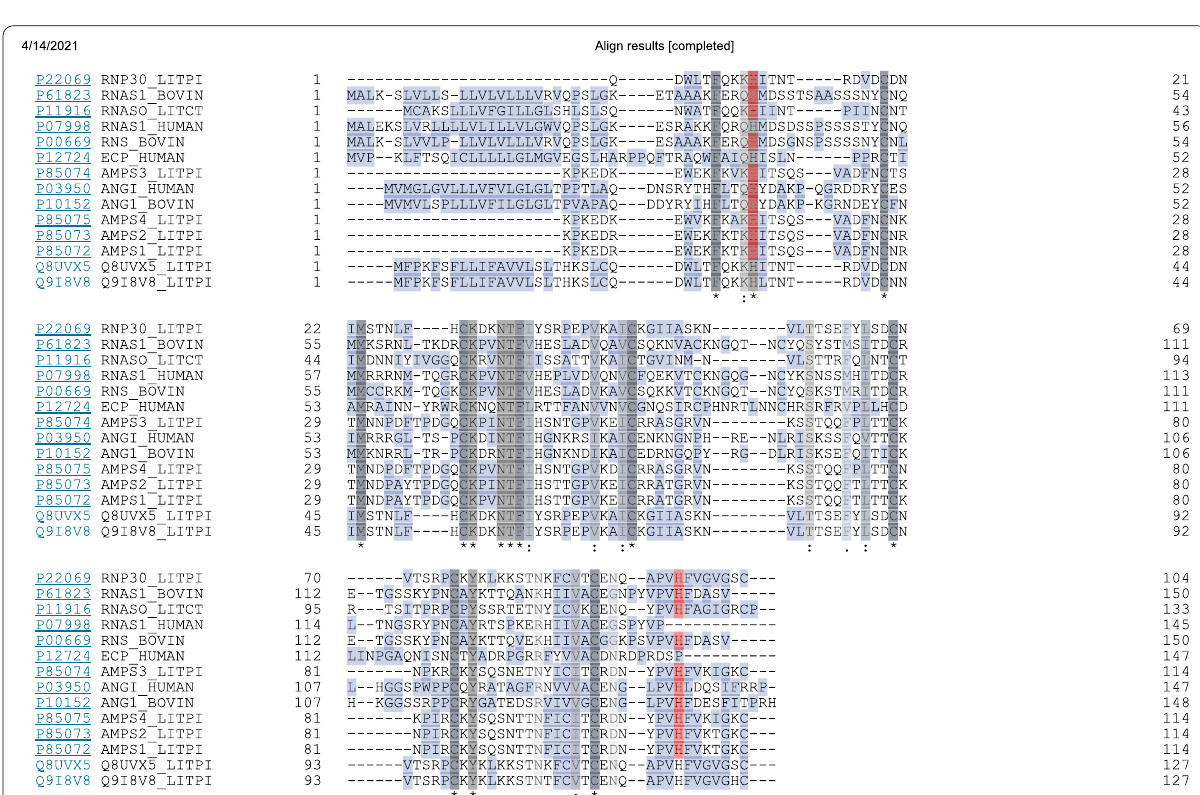
Fig. 1 Active site annotations and amino acid properties of multiple sequence aligned protein sequences of eukaryotic ribonucleases. An asterisk (*) indicates positions which have a single and fully conserved residue, a colon (:) indicates conservation between groups of strongly similar properties—scoring > 0.5 in the Gonnet PAM 250 matrix, a period (.) indicates conservation between groups of weakly similar properties— scoring < 0.5 in the Gonnet PAM 250 matrix. Red color shaded – active sites of protein sequences, Gray color shaded – identical positions of = protein sequence and Blue color shaded – hydrophobic positions of protein sequences